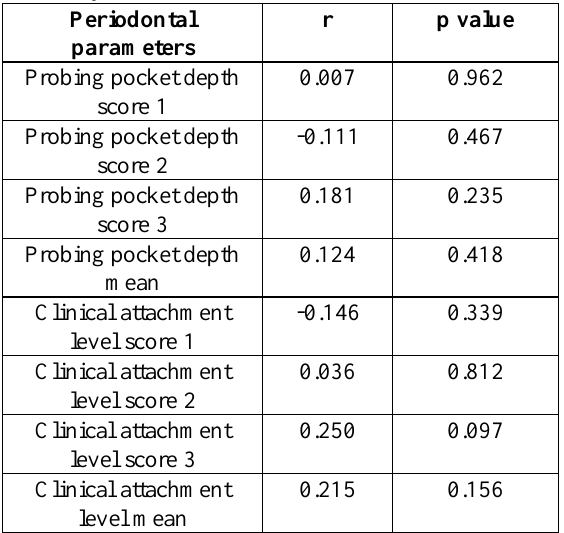
Table 2: Correlation Coefficient between